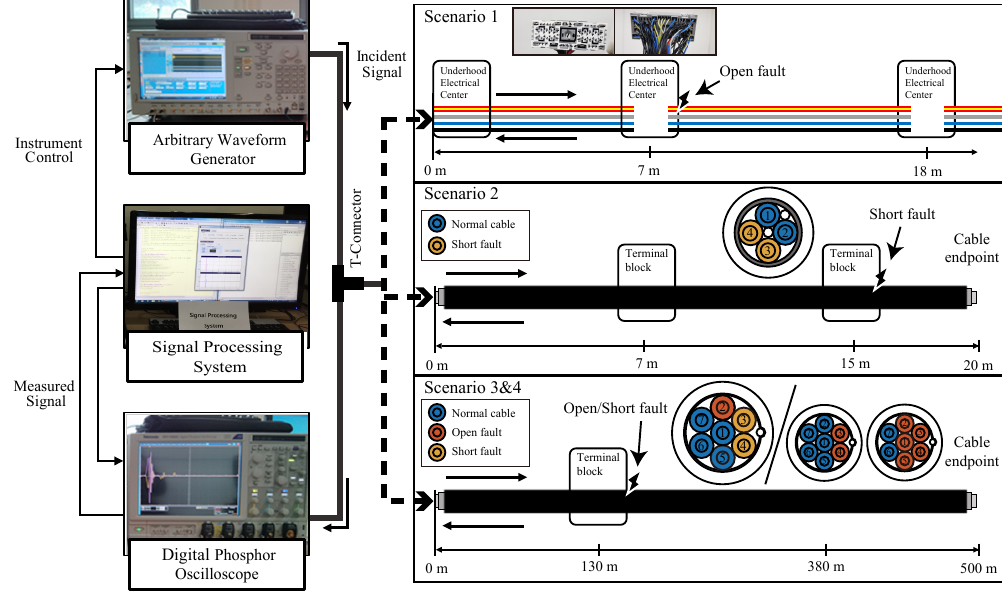
Figure 4. Schematic diagram of the TFDR